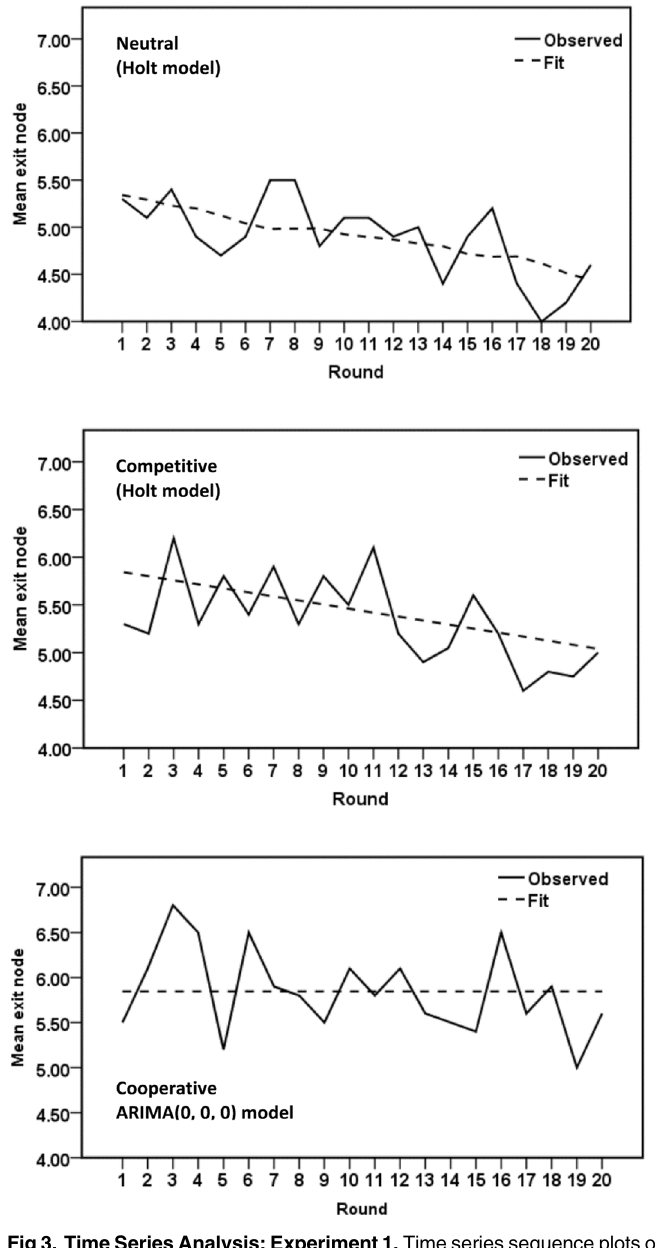
Fig 3. Time Series Analysis: Experiment 1. Time series sequence plots of mean exit nodes in Experiment